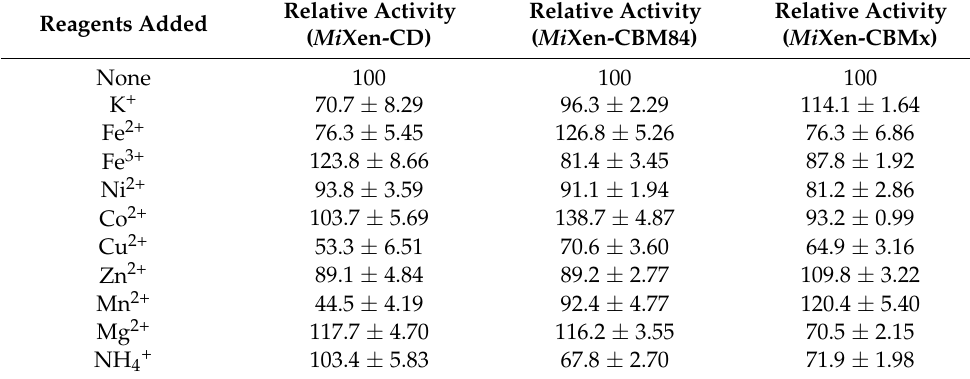
Table 2. Influence of different metal ions on activities of the endotype xanthanases.